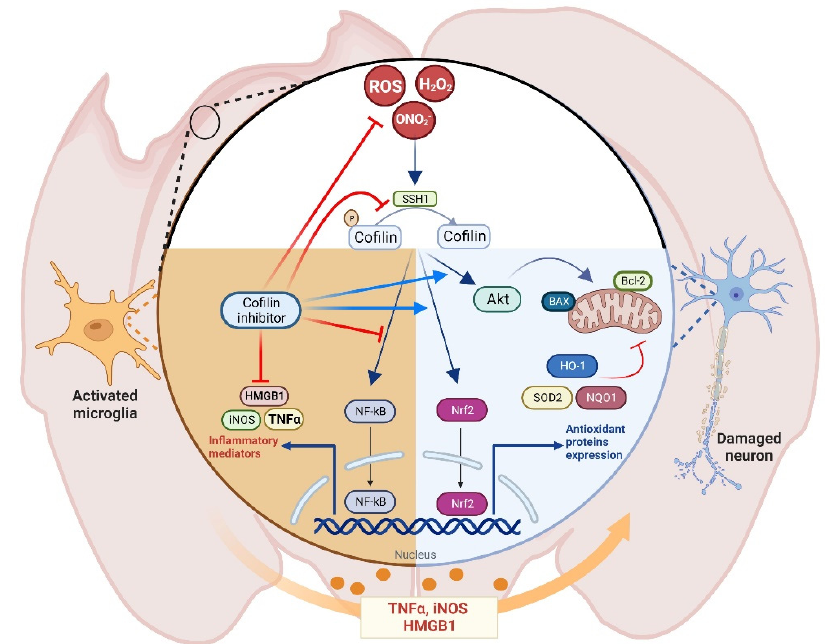
Figure 8. The proposed mechanism of cofilin inhibitor in TBI. Cofilin signaling is activated during oxidative stress conditions in microglial and neuronal cells. In microglia, ROS activates the NF-kB pathway, which regulates the expression of different cytotoxic mediators such as TNF α , HMGB1, and iNOS, an effect that is augmented by cofilin inhibitor treatment. In neurons, cofilin inhibitor activates the Nrf2 pathway, which regulates the expression of antioxidant enzymes and increases the Akt phosphorylation, leading to reduced expression of mitochondrial apoptotic markers and reduced neurotoxicity.